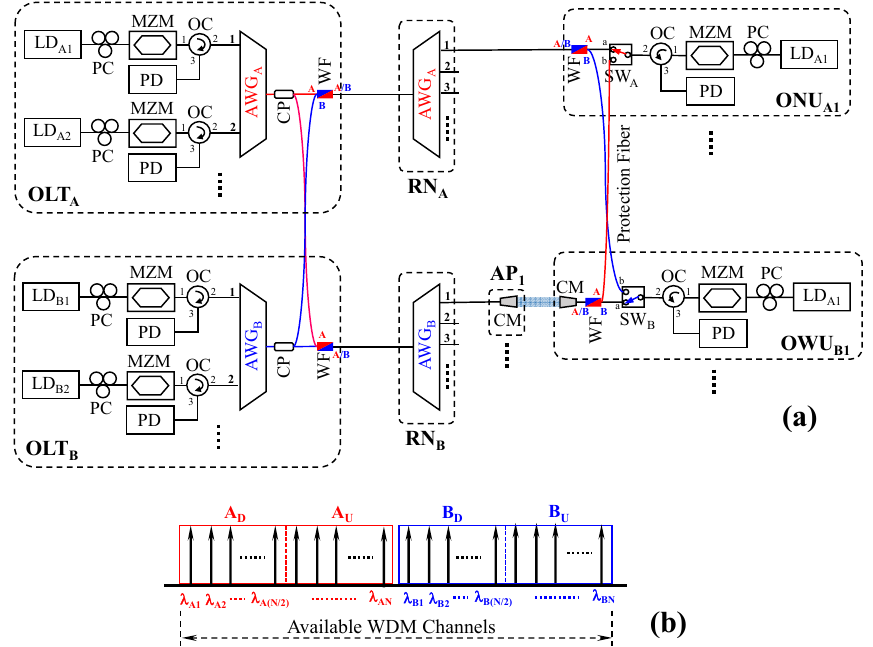
Figure 1. ( a ) Proposed hybrid self-restored FSO- and WDM-PON system with fault protection. ( b ) The periodic characteristic of AWG for the wavelength arrangement of fiber and FSO downstream (A D and B D bands) and upstream signals (A U and B U bands), respectively.